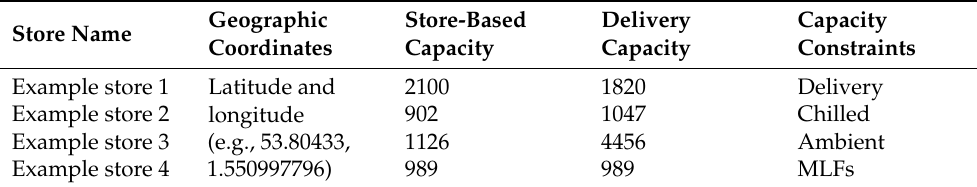
Table 1. Example capacity data provided by Sainsbury’s, related to their store network in 2019. ‘Store-based Capacity’ is reported as a relative value ranging from 388 to 3500, capturing store- level e-commerce storage and fulfilment capability. Delivery capacity is also a relative value (range 388–5124), capturing capacity associated with the last mile, and is not directly translatable into a count of orders that can be